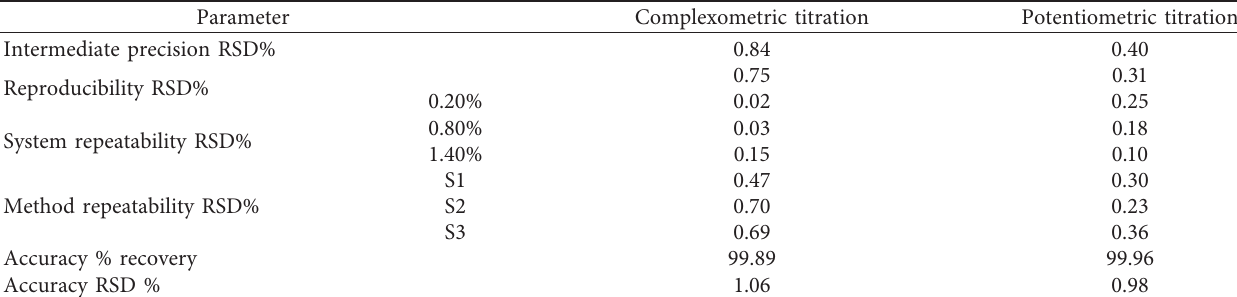
Table 2: Precision and accuracy ( n � 6) of the method for potentiometric and complexometric titration.